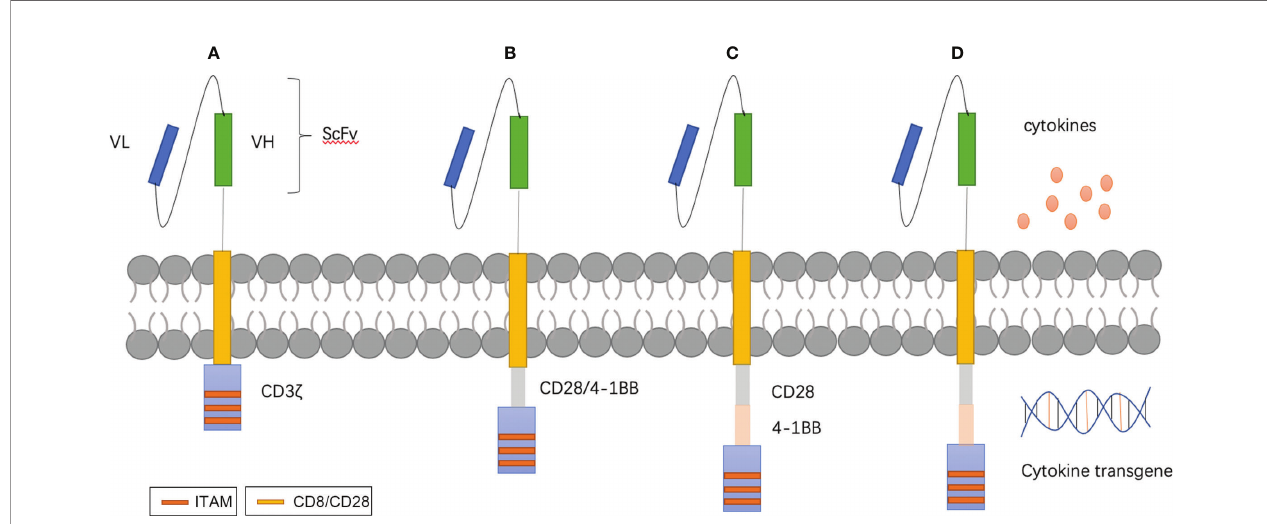
FIGURE 1 | T-CAR designs. (A – D) show the four generations of T-CAR. In brief, CAR contains three parts: extracellular domains are comprised of a single-chain variable fragment (scFv) for recognizing targeted antigen and transmembrane domains, and endocellular domains for transducing signals. First generation CARs consist of the basic structure with CD3 z (A) . Second generation CARs contain an additional costimulatory domain such as CD28 or 4 – 1BB (B) . Third generation CARs possess multiple costimulatory domains (C) . Fourth-generation CARs, also known as ‘ armored CARs ’ can be designed to secret cytokines to improve the proliferation, persistence.